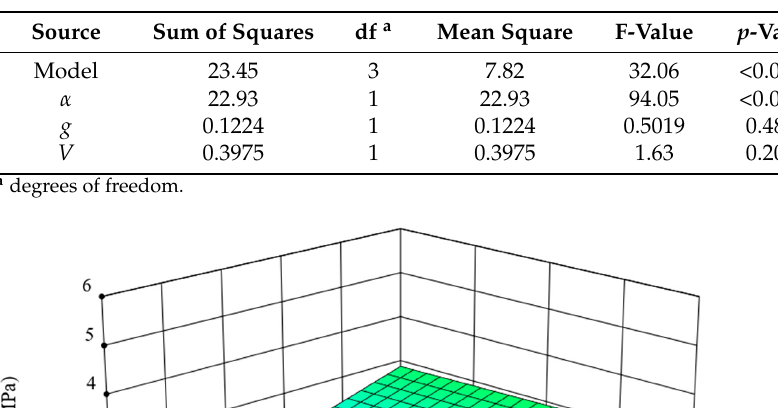
Table 4. ANOVA results. Dependent variable—ultimate shear stress— τ (MPa).